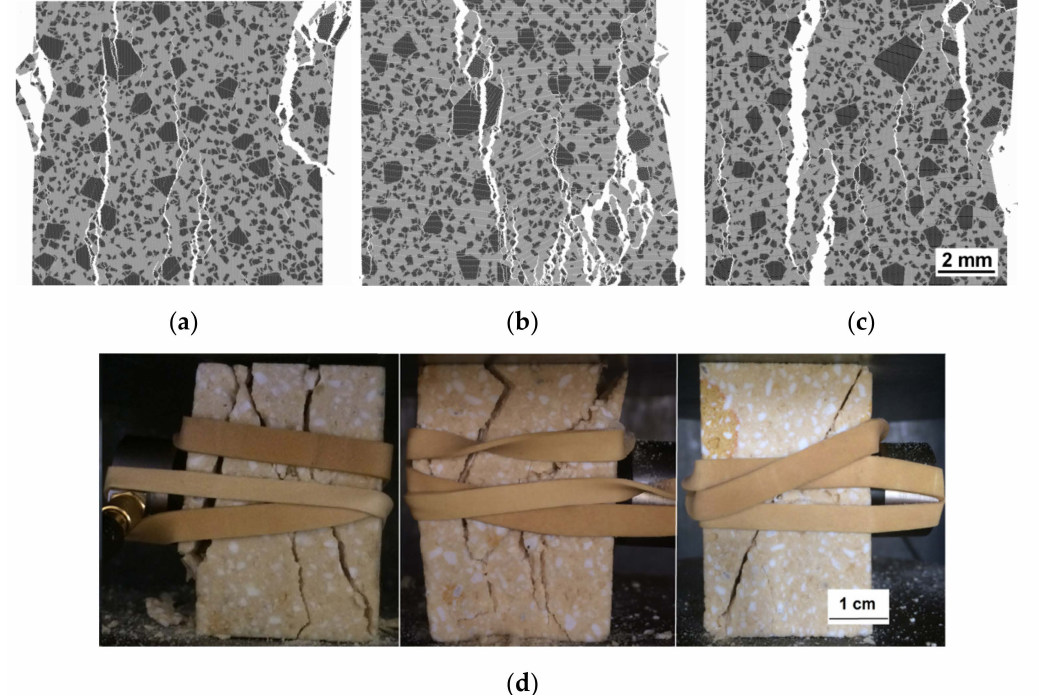
Figure 5. Crack patterns for uniaxial compression tests ( a – c ) models with final values of local strength parameters (1 × 1 cm 2 ) ( a – c ), typical crack patterns in the real samples ( d ).